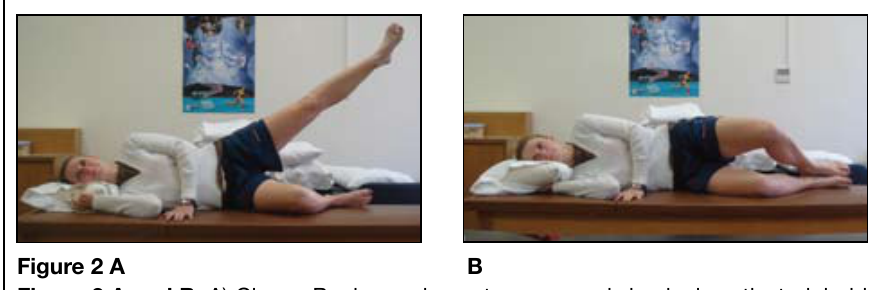
Figure 2 A B Figure 2 A and B: A) Clam – Beginner phase, transverse abdominals activated, hold the position and lift the knee. Repeat 8 times, three sets. B) Straight leg raise in side lying (progression of Clam). Side lying with transverse abdominal activated. Repeat 8 times four sets (Fredericson et al